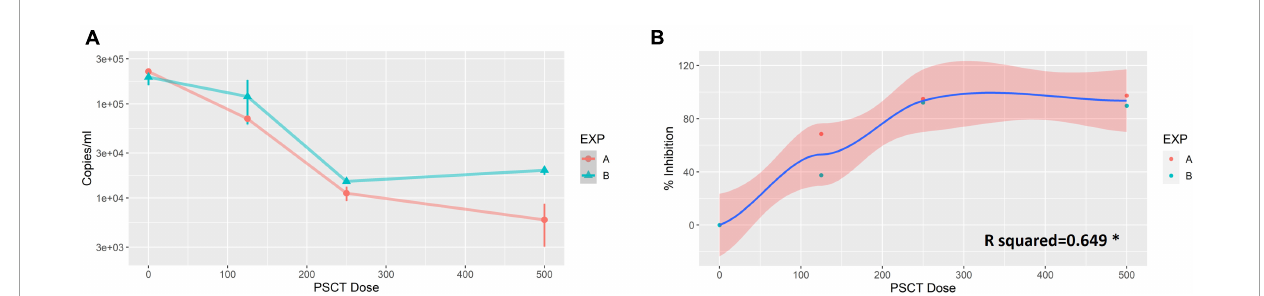
FIGURE2 Dose-dependent inhibition of SARS-CoV-2 replication in Vero E6 cells by liposome-encapsulated-PSCT treatment. Vero E6 cells were plated in 24-well plates and infected with SARS-CoV-2 viral stock at a low MOI. At 1 h p.i., the virus inoculum was aspirated, and corresponding cultures were treated with three serial dilutions of liposome-encapsulated-PSCT (500, 250 and 125 ng of PSCT per well), as detailed in the results section. (A) The supernatants were collected at 24 h p.i., and SARS-CoV-2 RNA load in the cell culture supernatant was determined by qPCR (genome copies/ml). (B) Depicting the positive correlation between PSCT dose and % inhibition of viral genome load in supernatants collected from the indicated treatment groups, as compared to mock treatment group (R squared = 0.649 by the linear regression model, ∗ p < 0.01). Data shown represent the mean ± SEM of two independent experiments, marked as EXP (A,B) , done in triplicates.